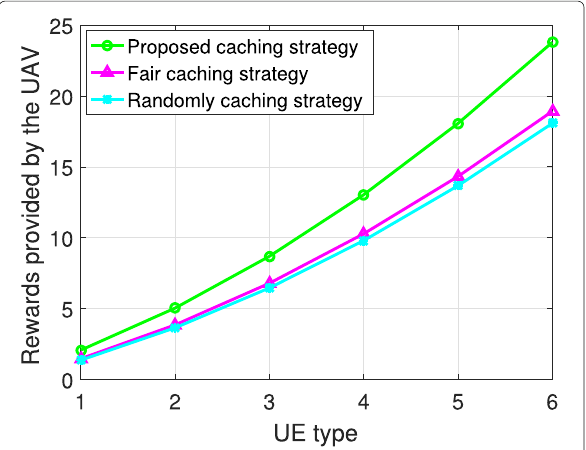
Fig. 3 Rewards provided by the UAV versus the UE